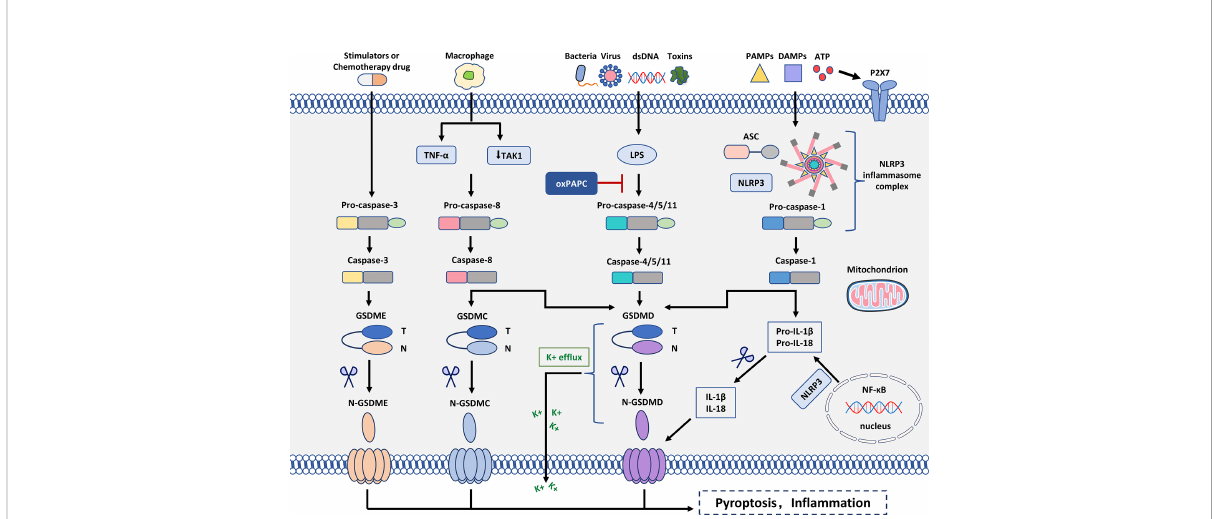
FIGURE 2 Molecular mechanism of pyroptosis. In the canonical in fl ammasome signaling pathway, PAMPs, DAMPs, and extracellular ATP are stimulated by intracellular signaling molecules and assembled with pro-caspase-1 and ASC to form in fl ammasomes and activated caspase-1. N-GSDMD perforates cell membranes by forming non-selective pores. In addition, IL-1 b and IL-18 were secreted in the pores formed by N-GSDMD. In the non-canonical in fl ammasome signaling pathway, intracytoplasmic LPS activates caspase-4/5/11, which triggers pyroptosis by cleaving